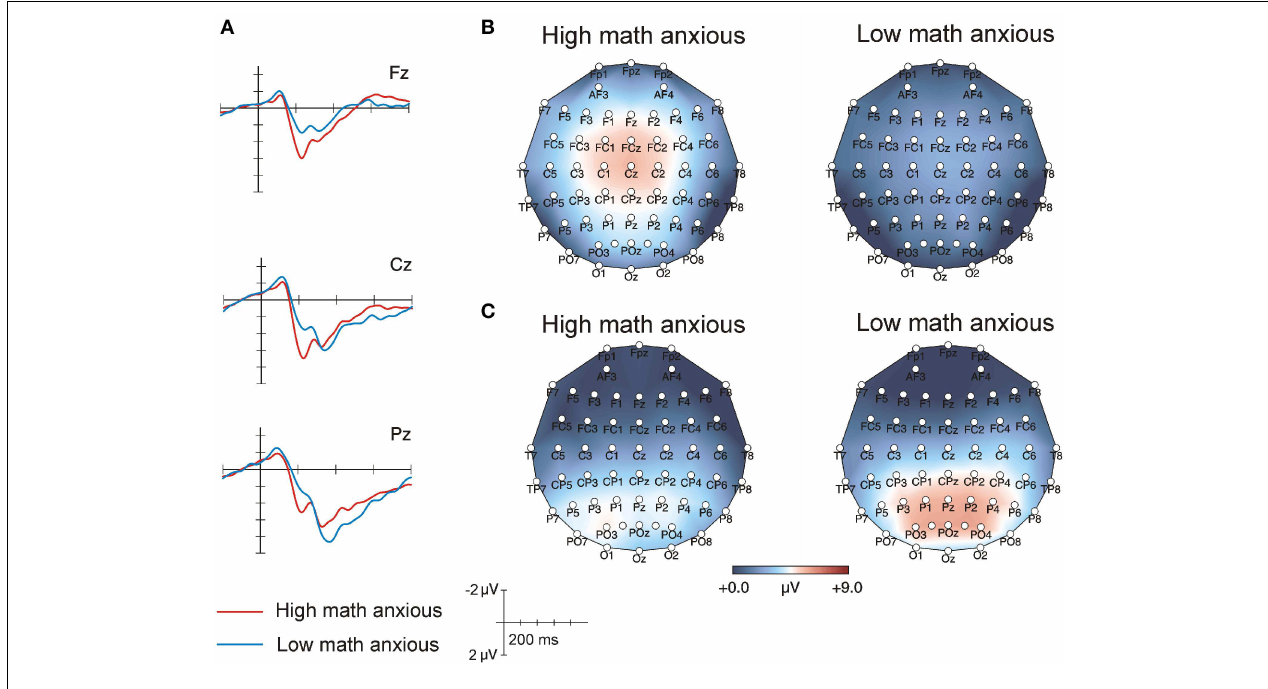
FIGURE 2 | (A) Raw averaged waveforms for HMA ( n = 17 ) and LMA ( n = 17 ) individuals during the verification phase when correct solutions were presented. (B) Topographic maps for HMA and LMA individuals in the